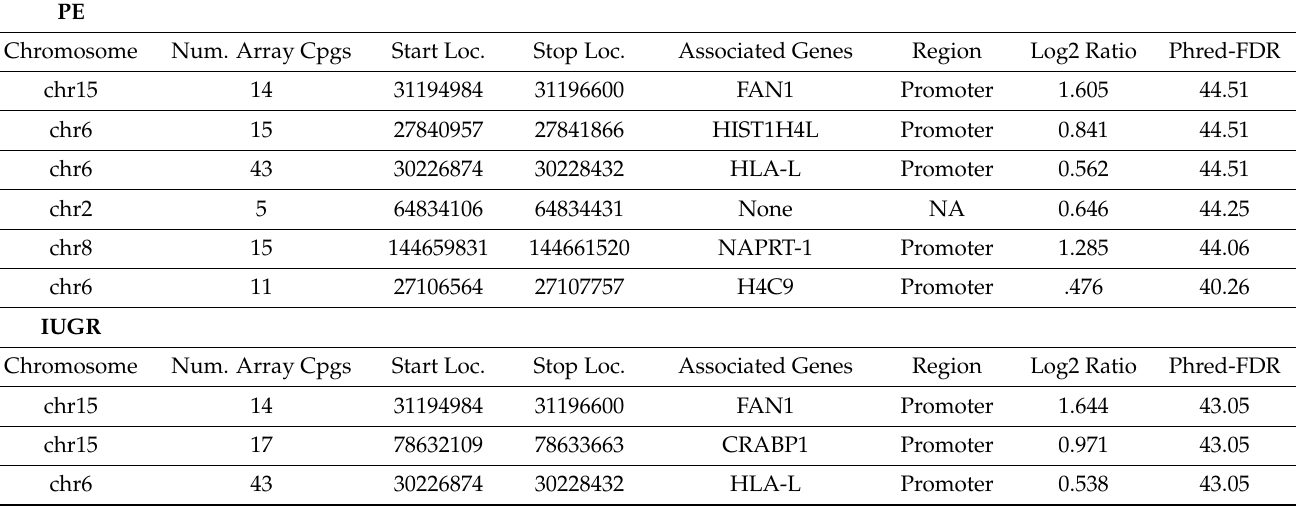
Figure 3. Shared areas of hypomethylation at key regulatory regions in both PE and IUGR placental Box plots were used to represent mean beta values at differentially methylated regions. tissues. Bar plots indicating methylation beta-values at signi fi cantly hypomethylated regions (FDR We generated box plots for average methylation values for all CpG sites in each region. > 40) in IUGR and PE samples compared with control ( A ). Venn diagram of each hypomethylated Regions associated with PE are shown in red, IUGR in green, and control in blue. These gene promoter region associated with PE and IUGR ( B ). plots depict statistically significant differences between the control group and either the PE or IUGR group. (Figure 3A). Of those regions, one IUGR region was associated with the promoter regions of the CRABP1 gene (Figure 3B). Three of the six PE regions were associated with either HIST1H4L, NAPRT1, or H4C9 gene promoter (Figure 3B).